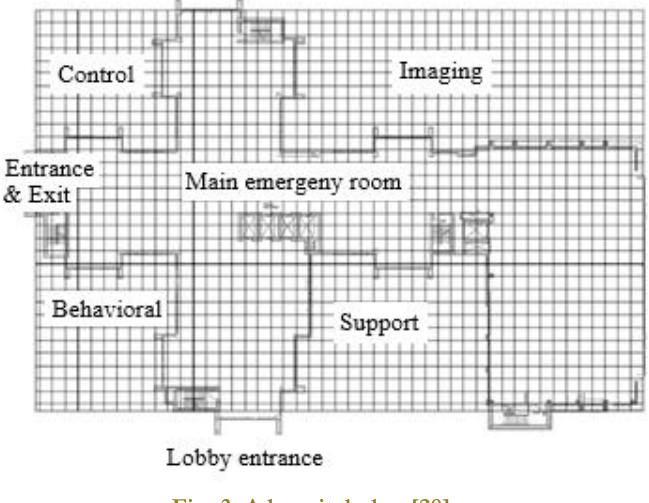
Fig. 3. A hospital plan